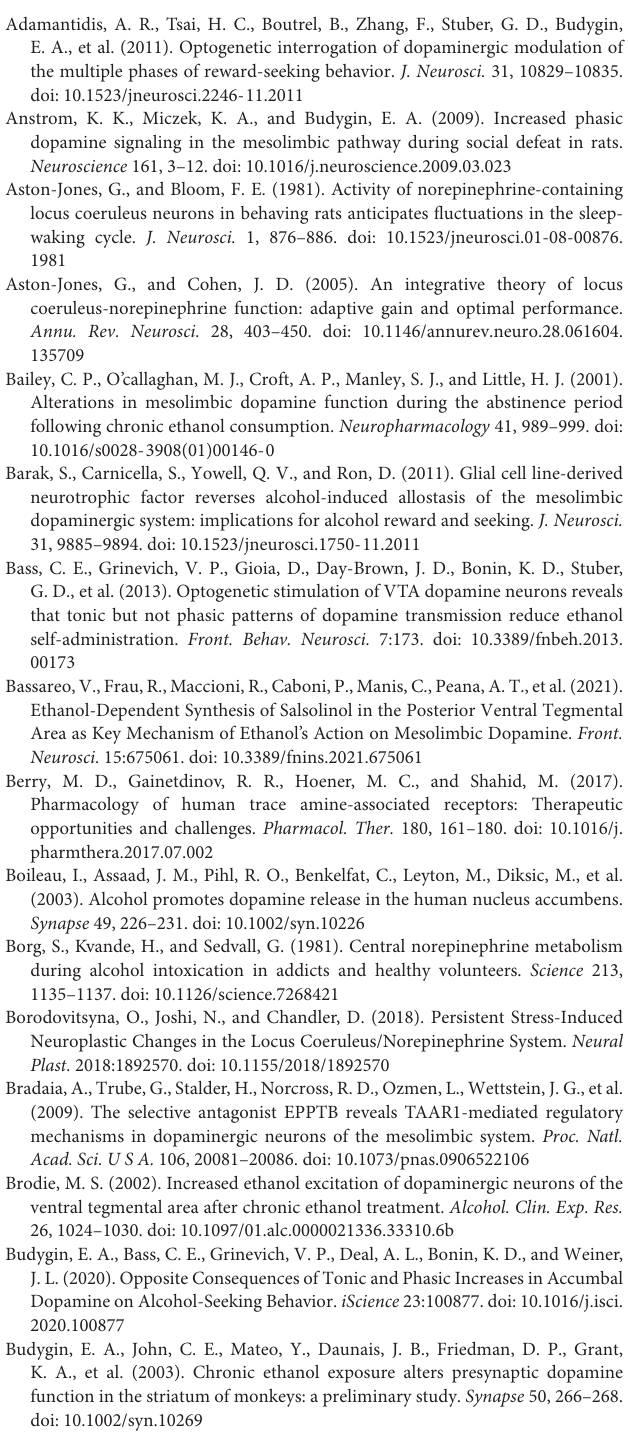
laser of 473 nm with a 100-mW power output. The star (*) indicates that intake measures were performed 3 h following optical stimulations conducted in in high ethanol drinking mice in their home cages. In all other experiments, the stimulations were applied within drinking